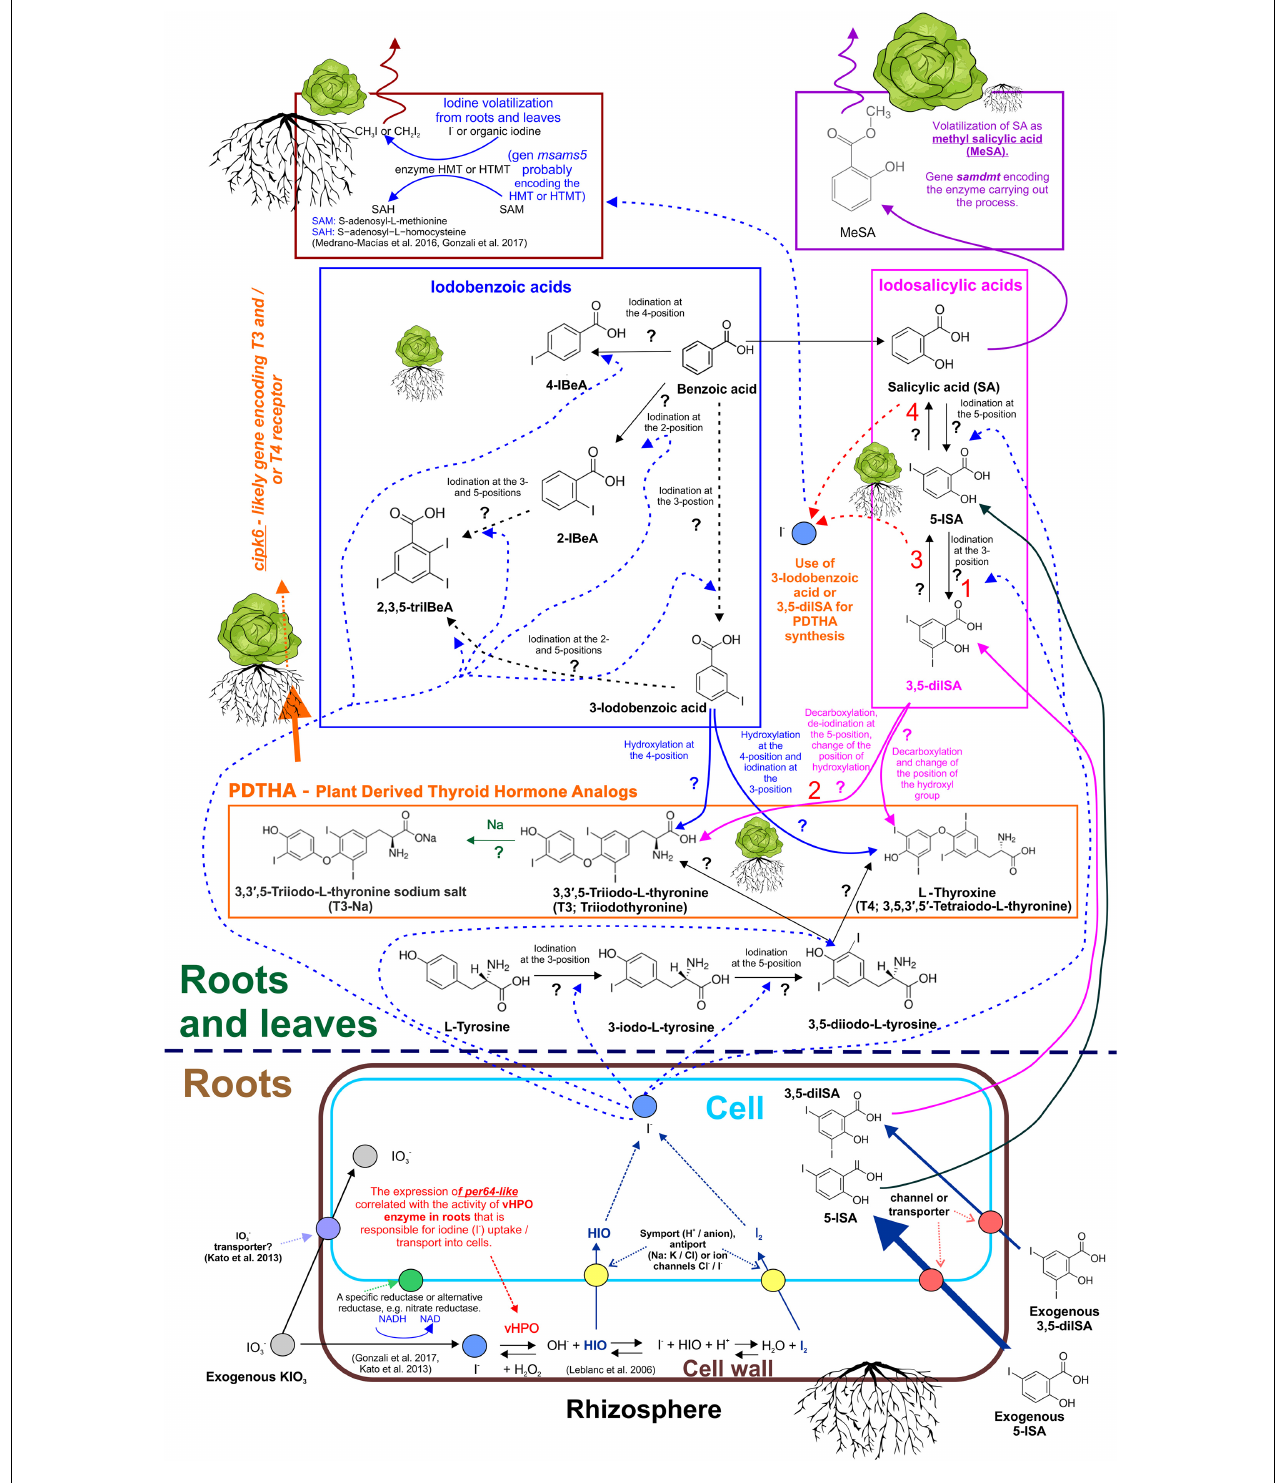
FIGURE 5 | Mechanism of uptake of non-organic and organic iodine compounds. Theoretical metabolic pathway of iodosalicylates, iodobenzoates, and plant-derived thyroid hormone analogs (PDTHA) in lettuce—summary of the study and literature data. 1 and 2—Processes that mainly occur in roots. Foliar activity intensifies after application of 5-ISA and 3,5-diISA. 3—Deiodination of 3,5-diISA. Observed increased content of 5-ISA following exogenous application of 3,5-diISA. 4—Deiodination of 5-diSA. Observed increased content of SA following exogenous application of 5-diSA and 3,5-diISA. ?— Undefined enzymatic/metabolic processes that carry out these